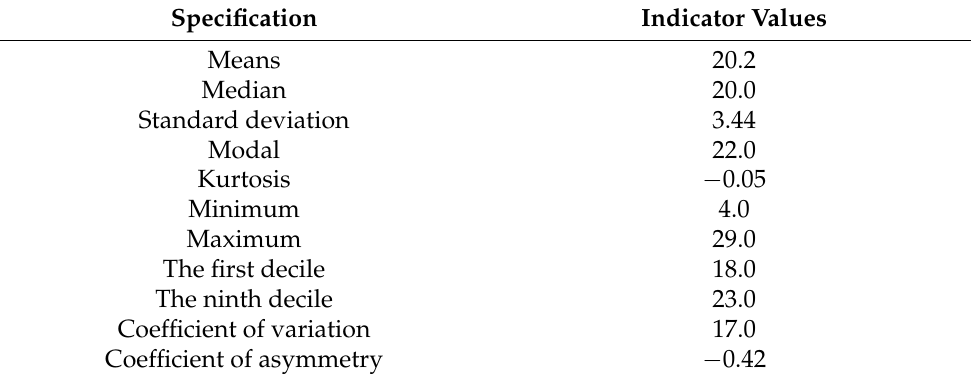
Table 2. The values of descriptive statistics of the aggregate index for households of people aged 60 and